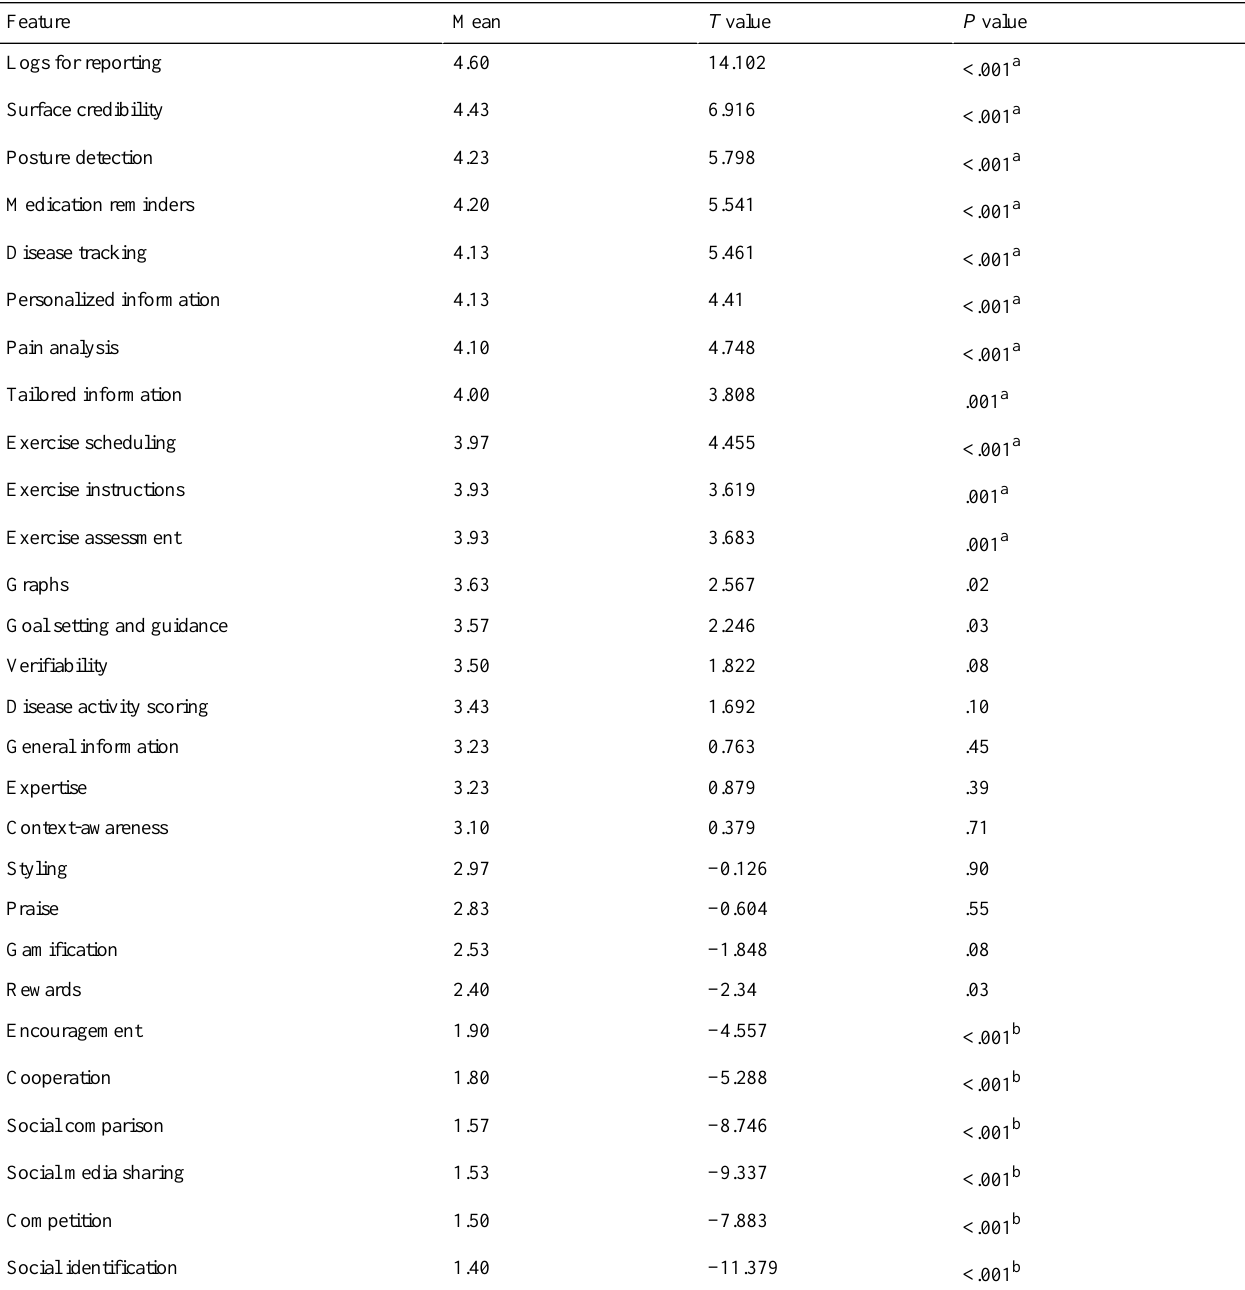
Table 3. Quantitative results of the interviews. Features are sorted based on the mean score.